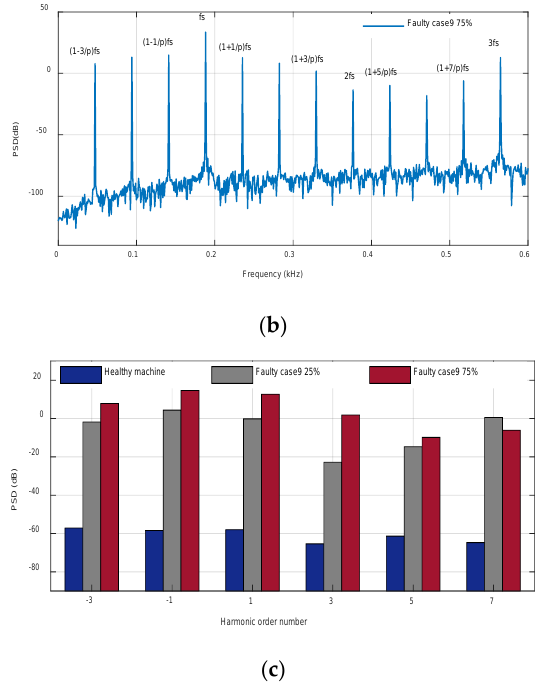
Figure 31. Faulty case 9: ( a ) PMSM current spectra normalized plot under 25%; ( b ) PMSM current spectra normalized plot under 75%; ( c ) ASBCs harmonics variations.